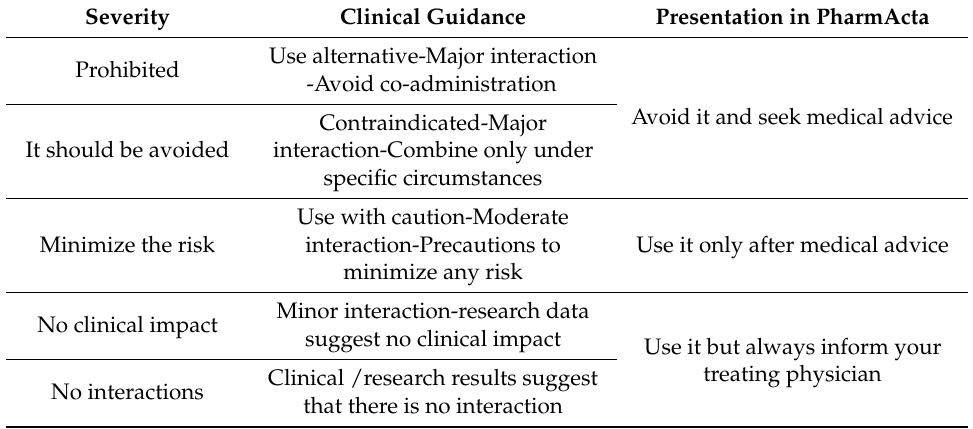
Table 1. Clinical significance of drug–HMP interactions as they are characterized in PharmActa (adopted from Refs.